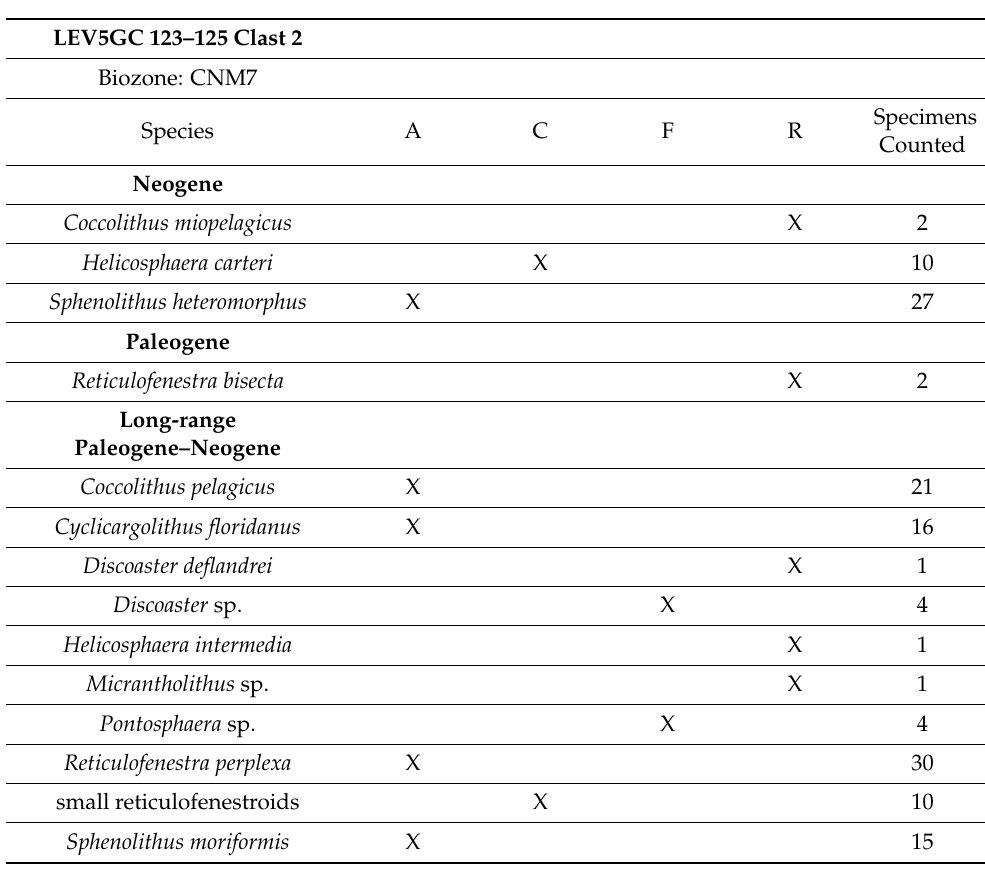
Table A28. Moscow MV.